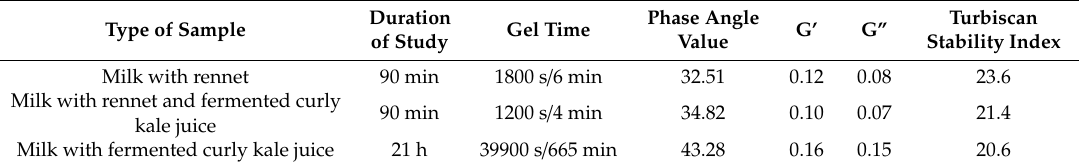
Table 1. E ff ect of addition of rennet and curly kale juice on the rheological parameters of cheese curds. Type of